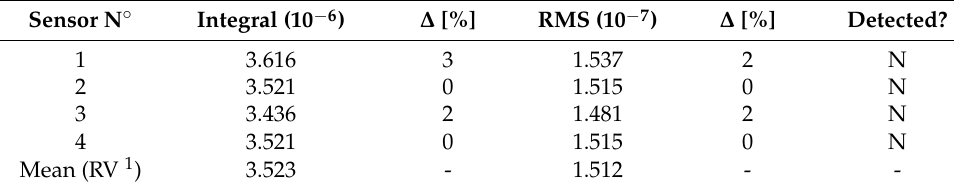
Figure 6. Frequency spectra, solid plate; expected frequency marked with dashed line. Table 2. Integral and RMS of frequency spectrum, solid